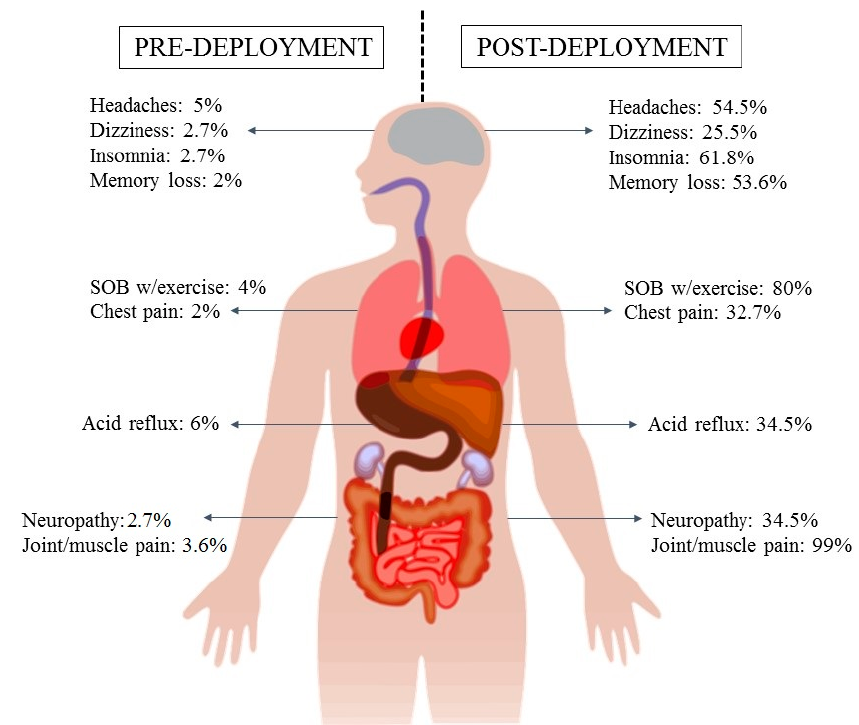
Figure 2. A Pictorial Depiction of Pre- and Post-Deployment Health Status of Iraq War Veterans (SOB = shortness of breath).